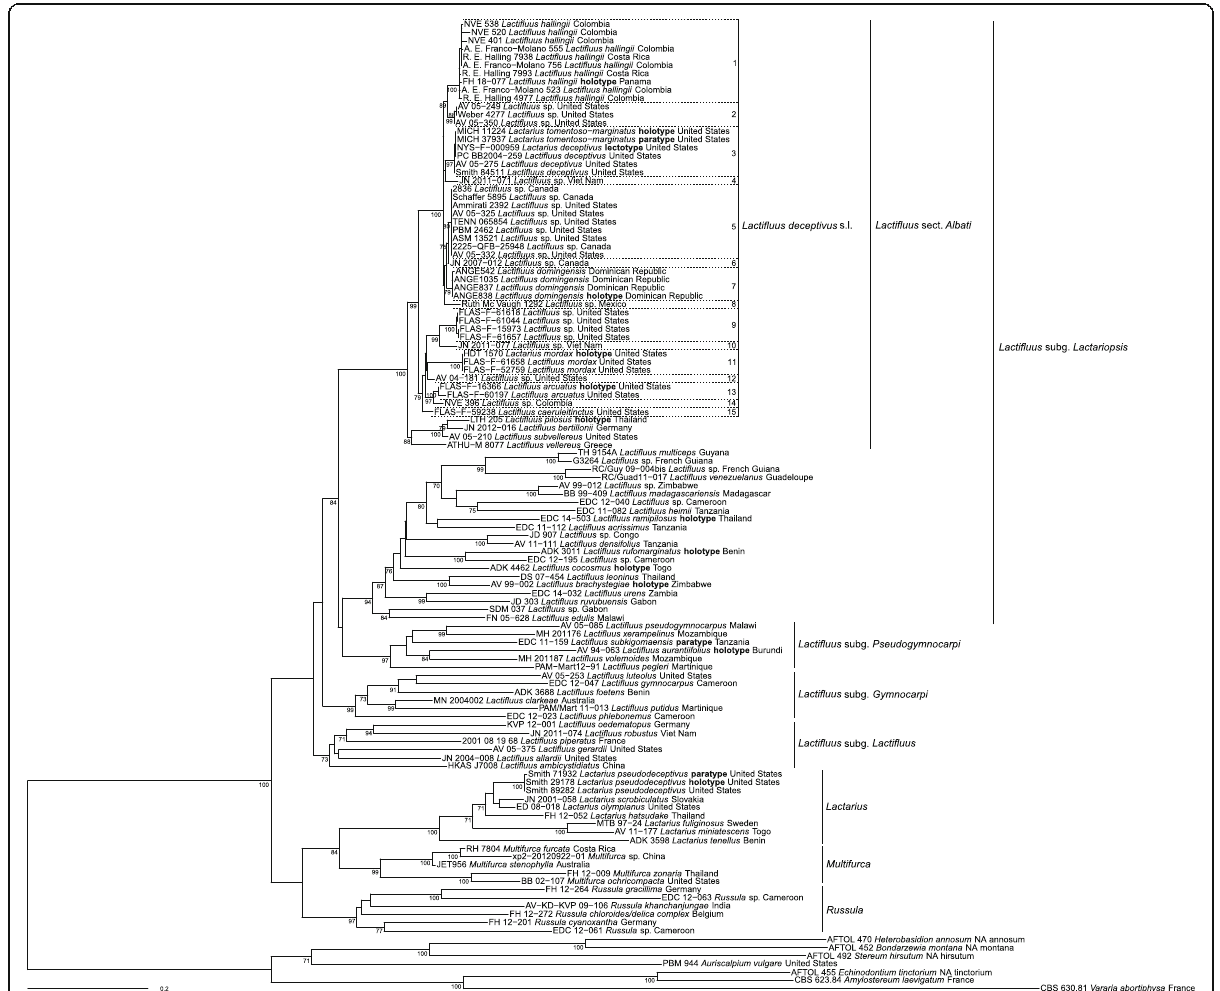
Fig. 1 Maximum Likelihood tree based on concatenated ITS and RPB2 sequence data. Maximum Likelihood bootstrap values > 70 are